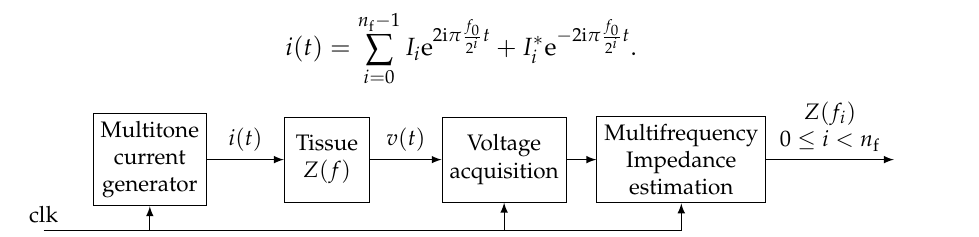
Figure 6. Principle of multi-tone synchronous bioimpedance sensing